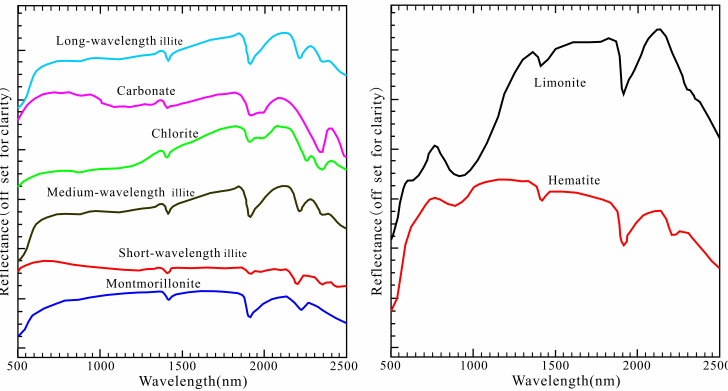
Figure 6. Spectral curves (500–2500 nm) of the eight investigated alteration minerals.